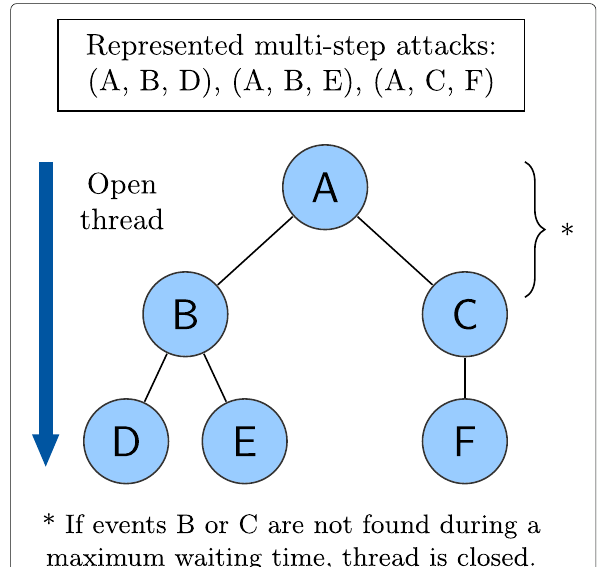
Fig. 1 Example of an event tree for classical correlation with three multi-step attacks